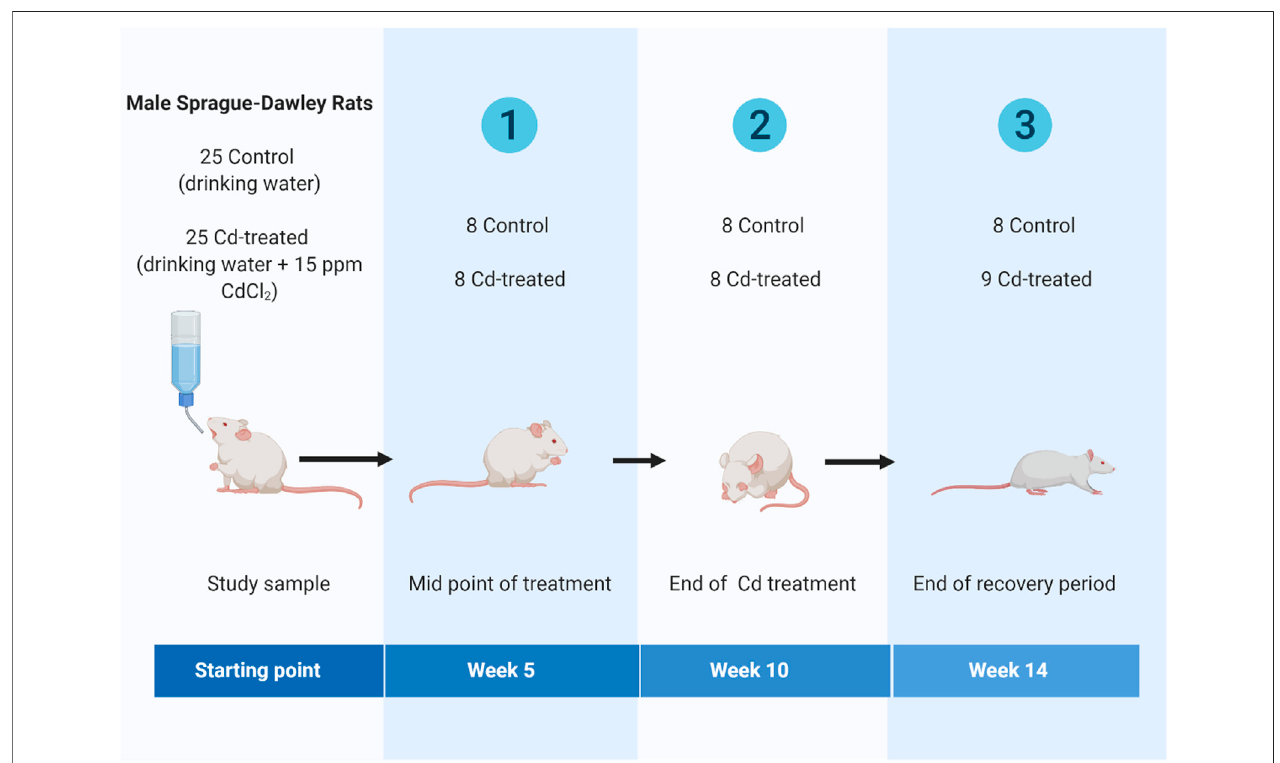
FIGURE 1 | Scheme illustrating the timeline of the study design(Created using Biorender).